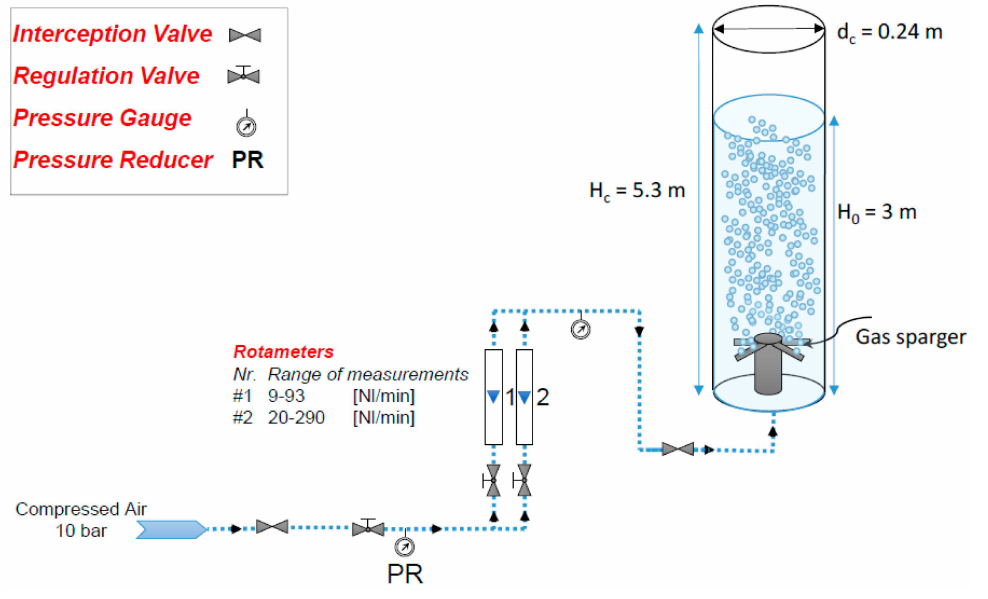
Figure 1. The experimental